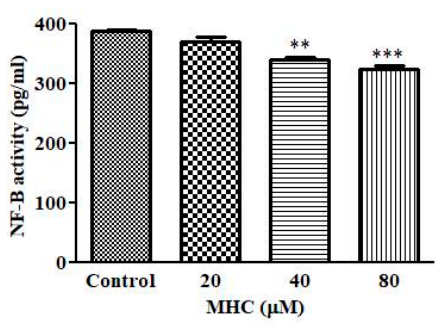
7 of 13 Figure 7. MHC-mediated instigation of intracellular ROS as assessed through ( A ) DCF-DA stained fluorescent photomicrographs and ( B ) quantification of DCF-DA-mediated mean fluorescence in- tensity within MCF-7 cells. * p < 0.05, ** p < 0.01 and *** p < 0.001. 2.9. MHC Treatment deflated NF- κ B Levels It is now an established fact that NF- κ B is pivotal in the survival and proliferation of